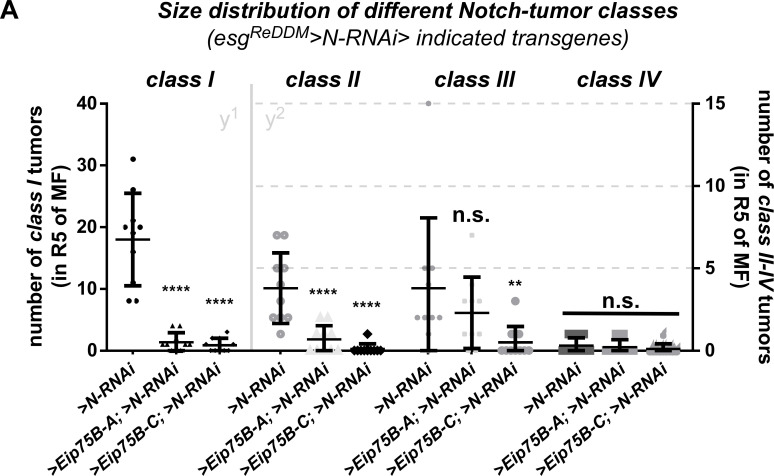
Size distribution of different Notch-tumor classes.(A) Quantification of ISC progeny encompassing ISC-like, EC and EE classified after tumor size (classes I to IV) in R5 PMG of esgReDDM > N RNAi (n = 10,10,10). Error bars are Standard Error of the Mean (SEM) and asterisks denote significances from one-way ANOVA with Bonferroni's Multiple Comparison Test (*p<0.05, **p<0.01; ***p<0,001; ****p<0.0001).Figure 6—figure supplement 1—source data 1.Data from Figure 6—figure supplement 1.Panel A experimental data.